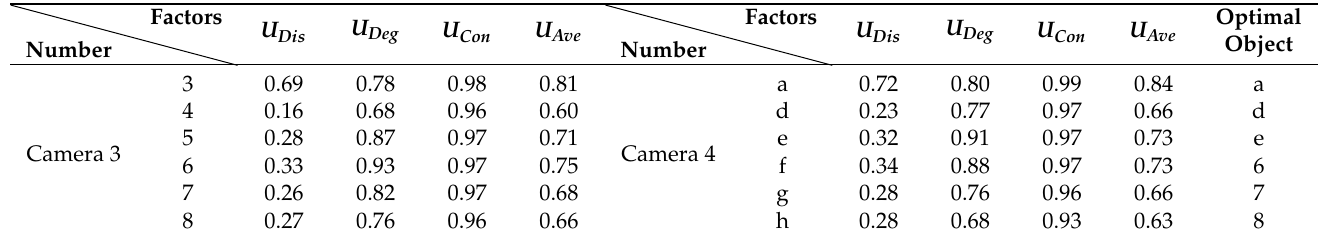
Table 3. The OS-CDD algorithm for an overlapping field in the parking